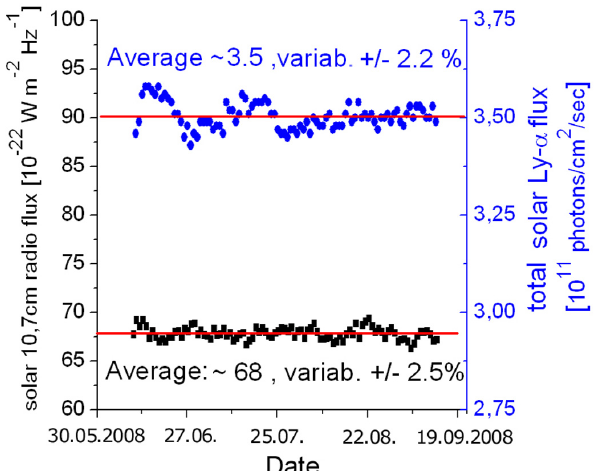
Fig. 2. The composite, total solar Lyman- α flux taken from TIMED SEE and SORCE SOLSTICE (upper blue graph) and the terrestrial solar 10.7cm radioflux taken from NGDC (lower black graph) both show a very low variability of 2.2–2.5% in the relevant time section between 11 June and 13 September